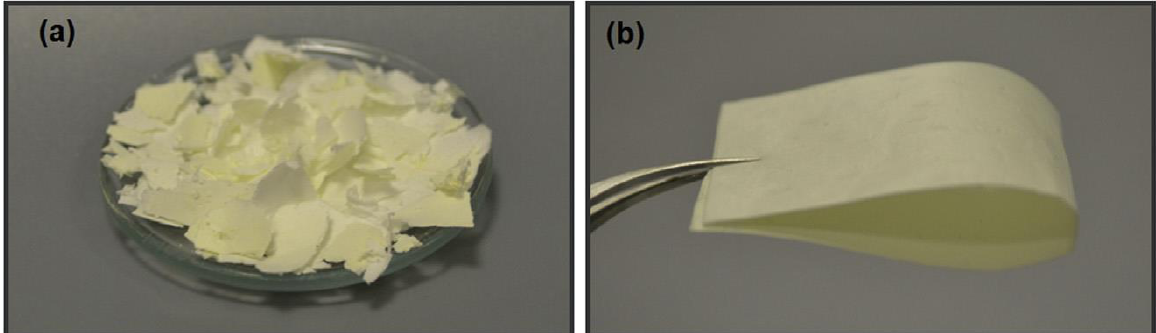
Figure 4. ( a ) A film made of PBA-ad6, and ( b ) electrospun nanowebs from 40% chloroform/DMF mixed solvent solution of PBA-ad6. (Reproduced from the work in [40] with permission.)